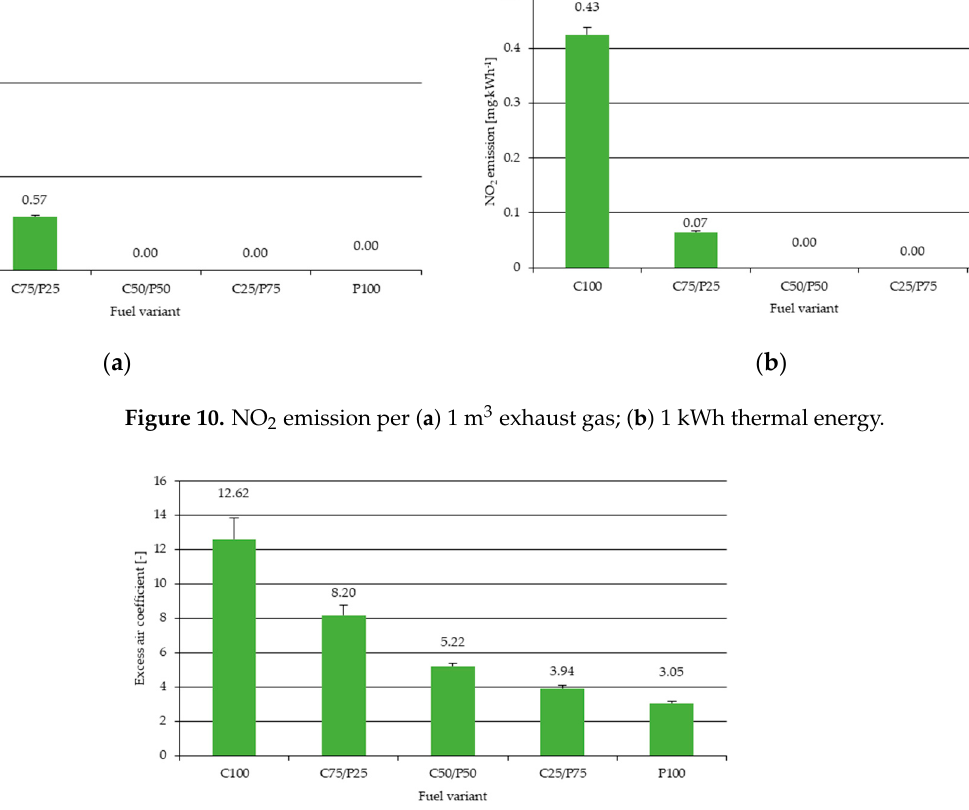
Figure 10. NO 2 emission per ( a ) 1 m 3 exhaust gas; ( b ) 1 kWh thermal energy.